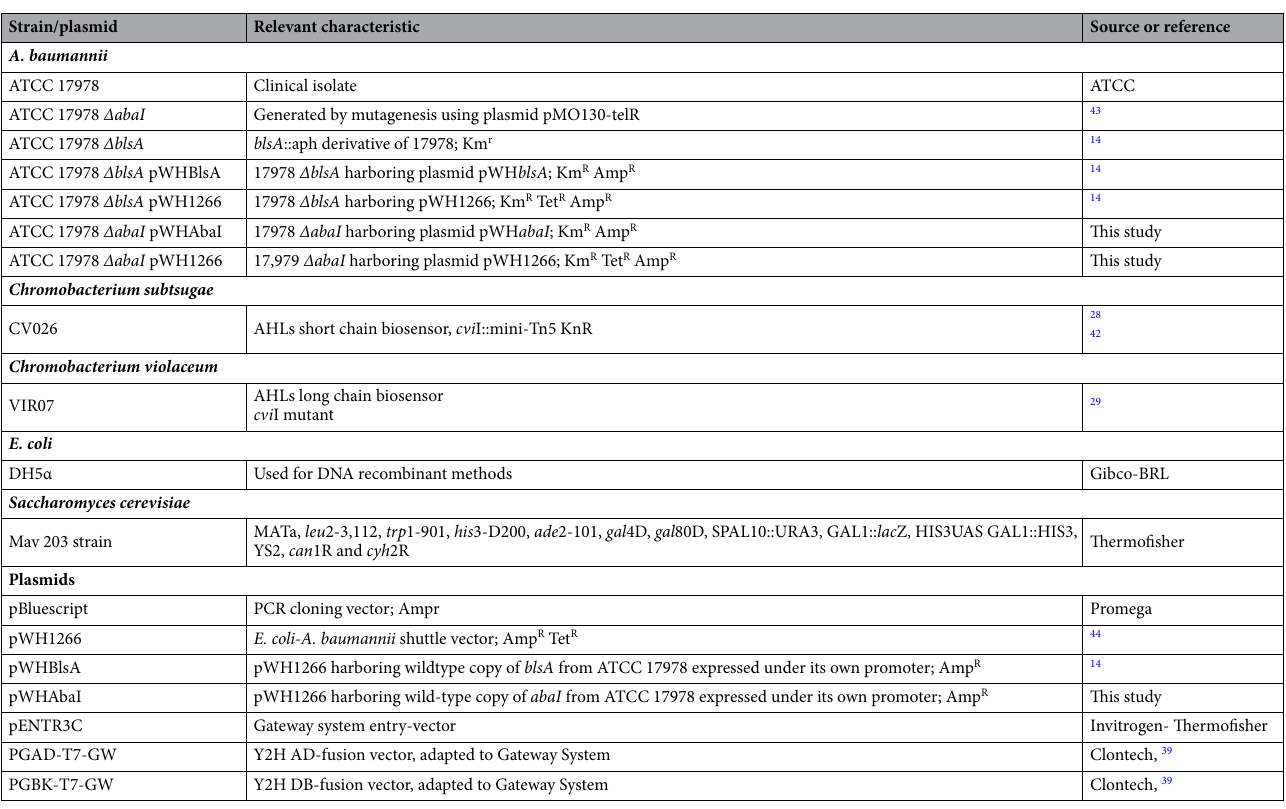
Table 2. Bacterial, yeast strains and plasmids used in this